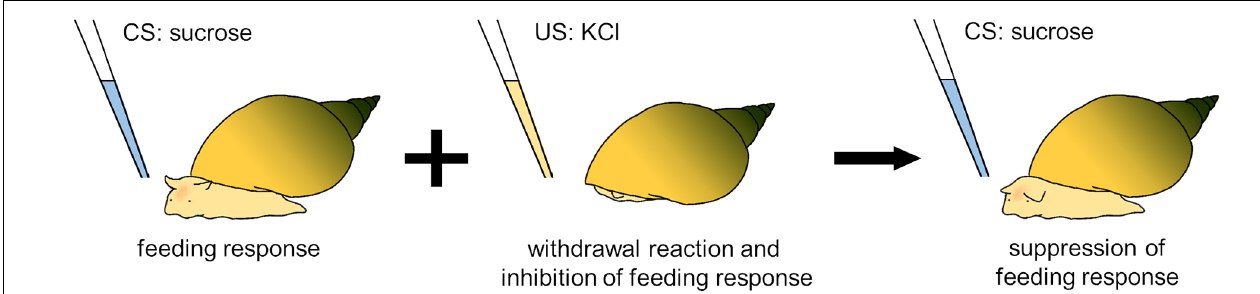
FIGURE 3 | Training protocol for conditioned taste aversion (CTA) in Lymnaea . After a sucrose solution (CS) is paired with a KCl solution (US), the sucrose solution does not elicit a feeding response in